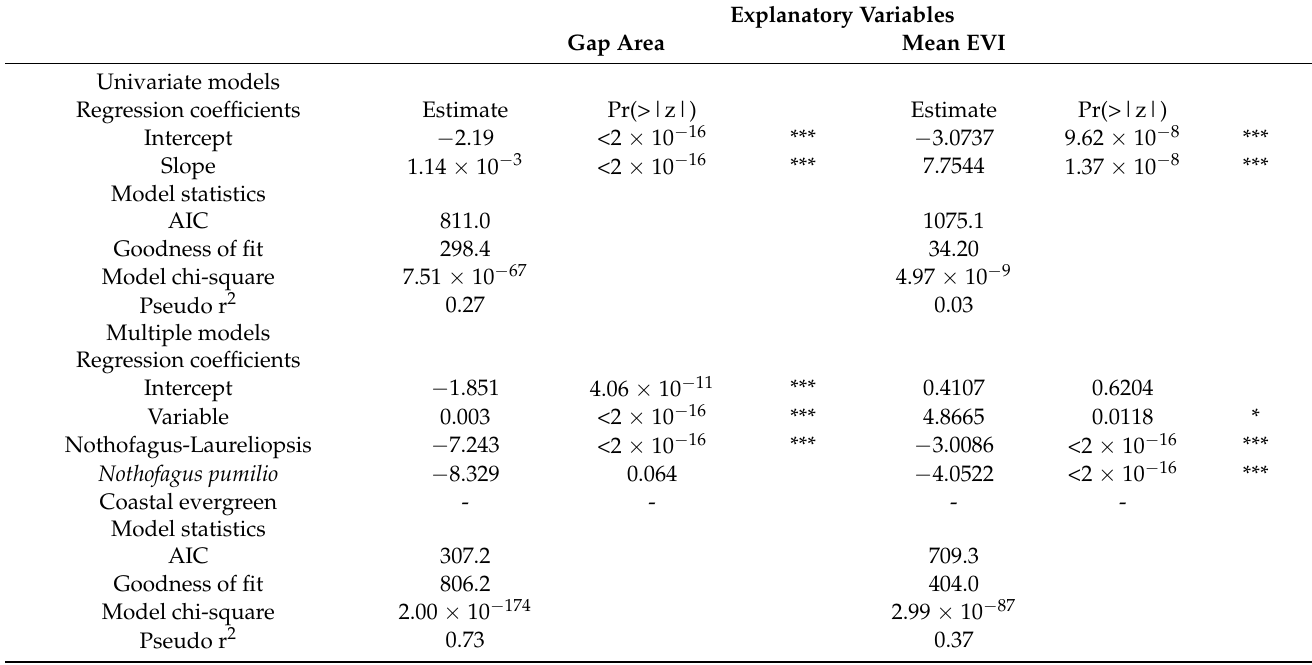
Table 3. Univariate and multiple logistic regression models that explain the variation of the total gap area and mean EVI with the degree of alteration (intact/altered) and forest type. AIC: Akaike information criterion. See also the Materials and Methods Section for an explanation of the statistical analysis. * indicates p < 0.01, *** indicates p <